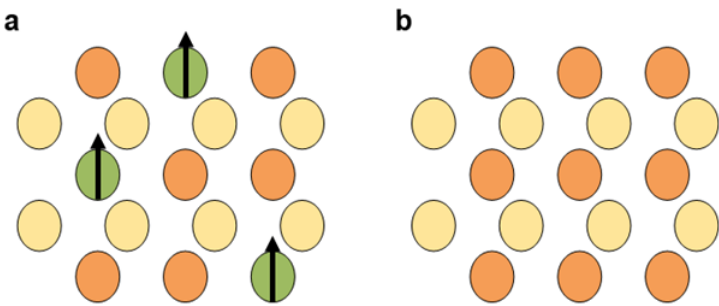
Figure 1. ( a ) Dilute magnetic semiconductor, ( b ) a nonmagnetic semiconductor, does not contain a magnetic ion.